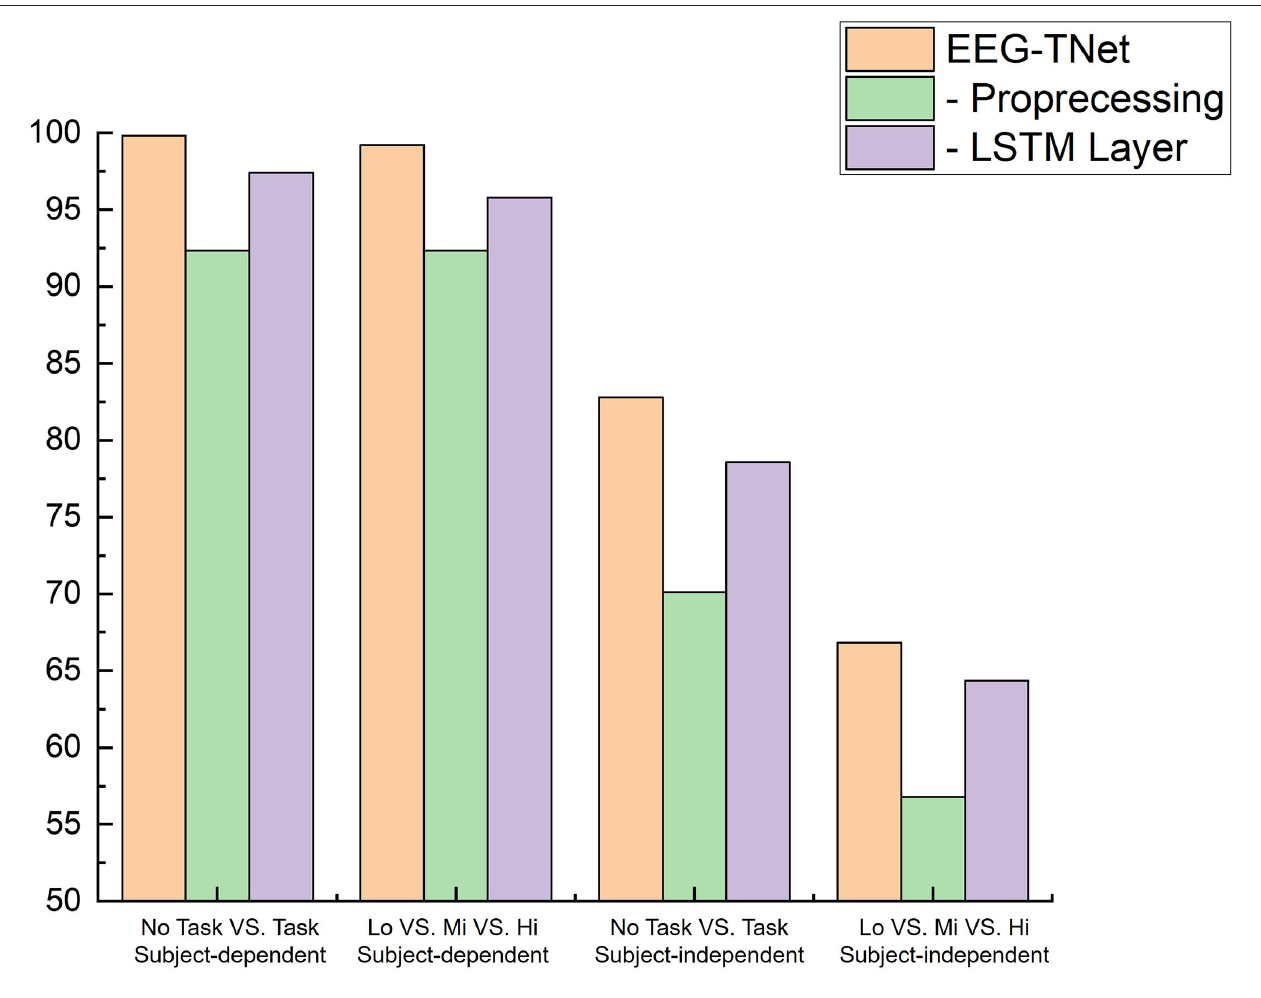
FIGURE 5 | Ablation